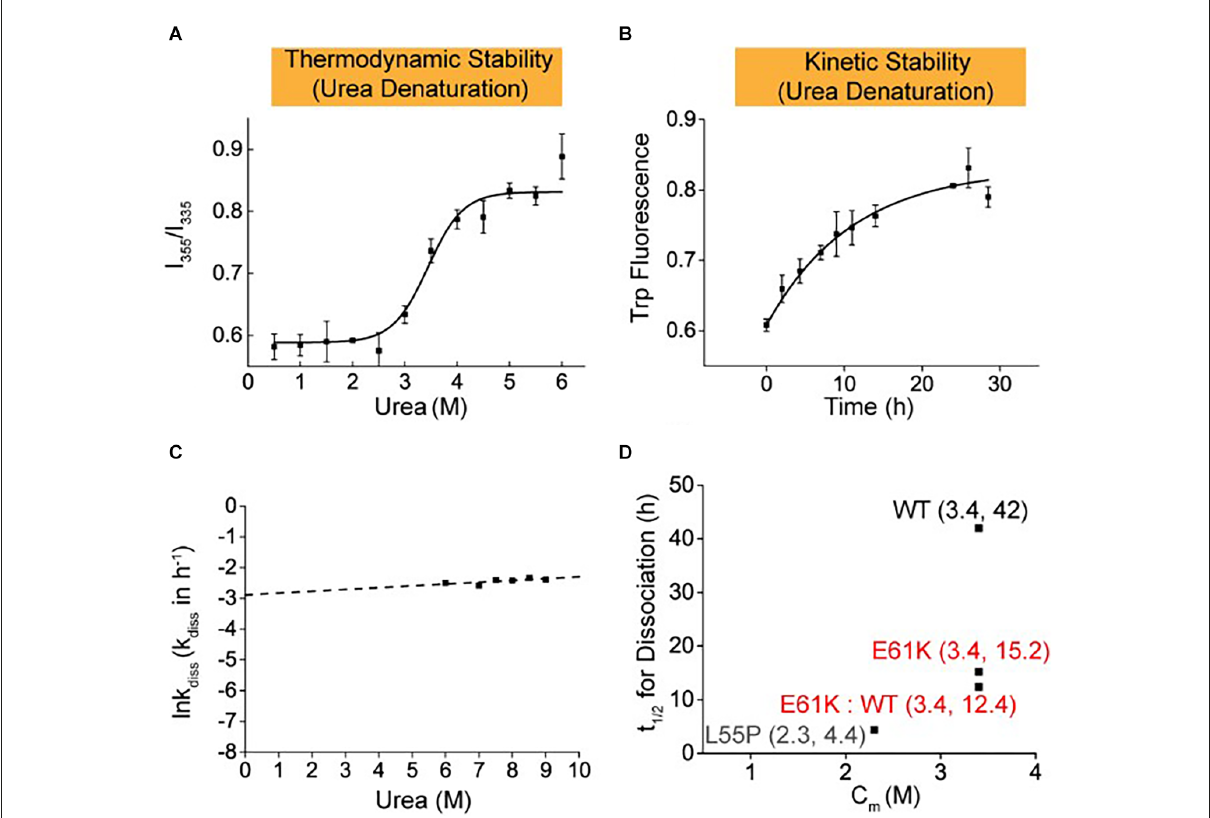
FIGURE3 Thermodynamic and kinetic stability of heterozygous E61K:WT-TTR mixture proteins. Heterozygous protein mixture mimicking the scenario in patients’ plasma was prepared by mixing E61K-TTR and WT-TTR in equal amounts at 4 ◦ C for 48 h to allow for sufficient subunit exchange. (A) Thermodynamic stability of E61K-TTR after subunit exchange with WT-TTR. (B) Kinetic stability of E61K-TTR after subunit exchange with WT-TTR. (C) The logarithm of the rate of tetramer dissociation, lnkdiss (kdiss in h-1), was plotted as a function of urea concentrations. The lnkdiss vs. urea concentration plot is linear, allowing extrapolation to 0 M urea. (D) Summary of thermodynamic (X-axis; Cm values) and kinetic (Y-axis; t 1/2 of tetramer dissociation) stability of heterozygous E61K:WT-TTR proteins. These results indicate E61K subunit can compromise the kinetic stability of WT, but WT subunit cannot stabilize